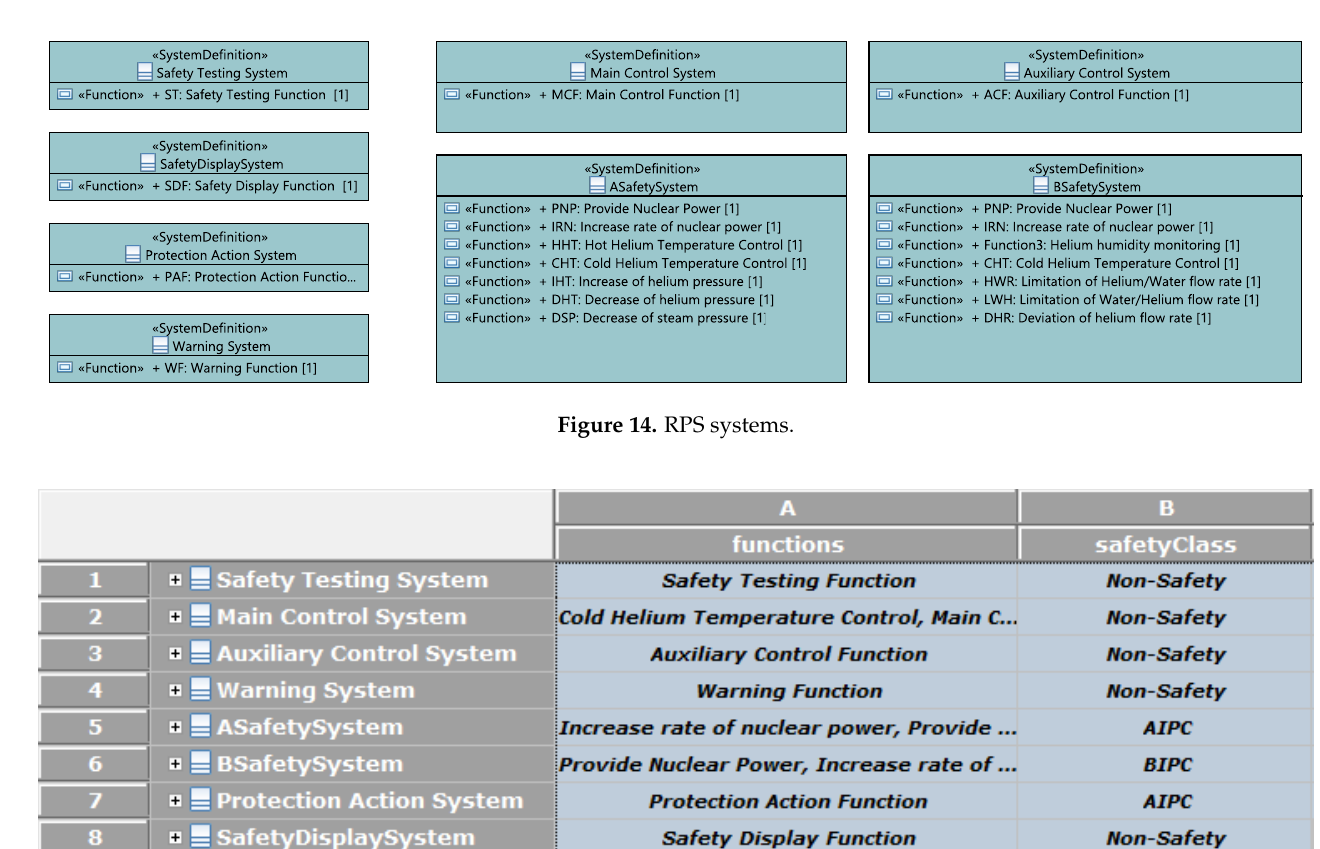
Figure 13. Tabular representation of the safety functions.